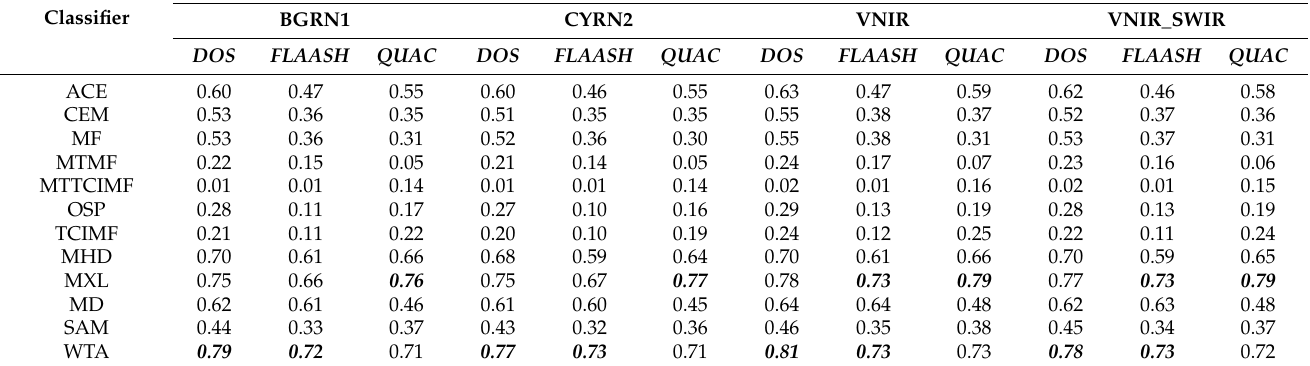
Table 7. Performance of the classifiers according to each atmospheric correction across all image subsets using OA as the evaluative measure. The values of the best performing classifiers are highlighted in bold and italicized.